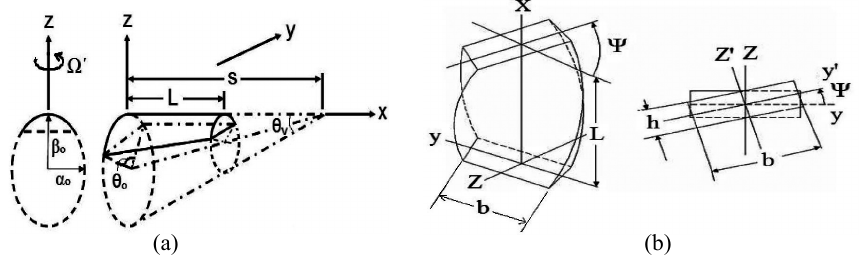
Fig. 1. Geometry of (a) Untwisted shallow conical shell and (b) Twisted